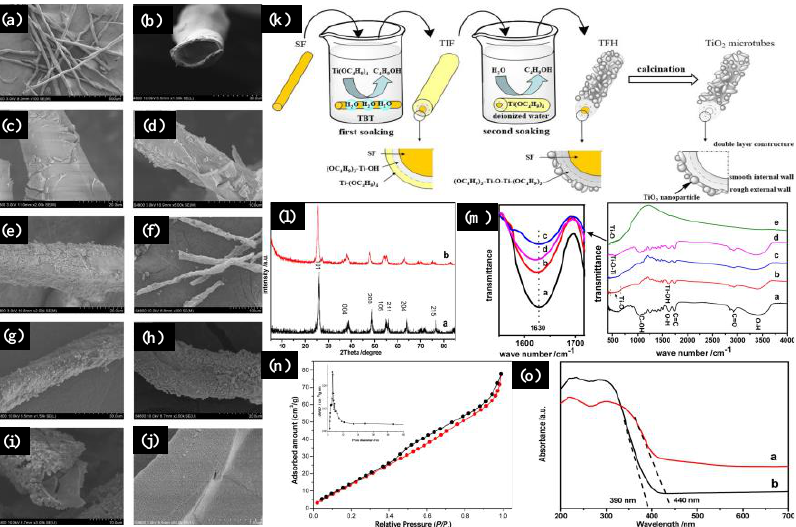
Figure 5. ( a , b ) Scanning electron microscopy images of the Platanus acerifolia seed fibers, ( c , d ) titanium sol-impregnated fibers (TIF), ( e ) titanium fiber hybrid (TFH), ( f – i ) hollow tubular TiO 2 microtubes, and ( j ) an inner wall of the TiO 2 microtubes. ( k ) Schematic of the double soaking sol-gel route for the preparation of TiO 2 microtubes. ( l ) The XRD pattern of the TiO 2 microtubes ( a ) and ( b ) their inner wall. ( m ) The FTIR spectra of the natural SFs ( a ) and TIF ( b ), TFH ( c ), and TiO 2 microtubes ( d ) prepared from the natural SFs. ( n ) The BET surface is a pore-size distribution of the TiO 2 microtubes. ( o ) UV-Vis spectra of the commercially available TiO 2 ( a ) and synthesized TiO 2 microtubes ( b ). Figure adapted with permission from Reference [89]. Copyright 2017 Elsevier.